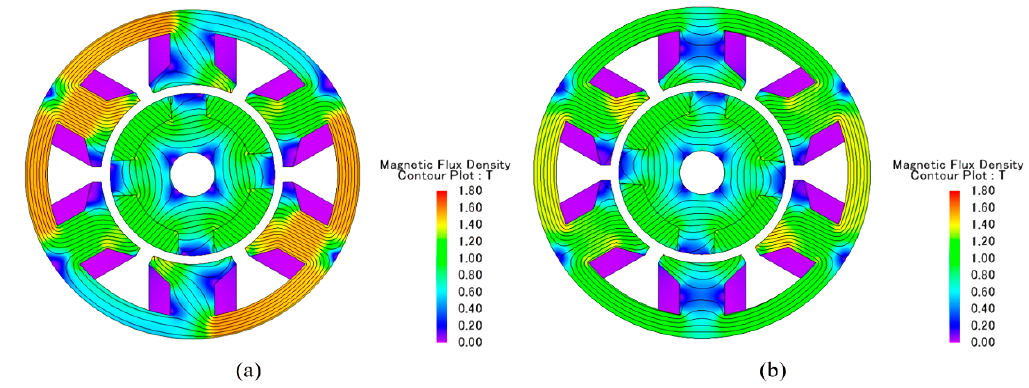
Figure 7. Magnetic flux density distributions of ( a ) 35CS300 and ( b ) Somaloy 700 1P motors at maximum torques.